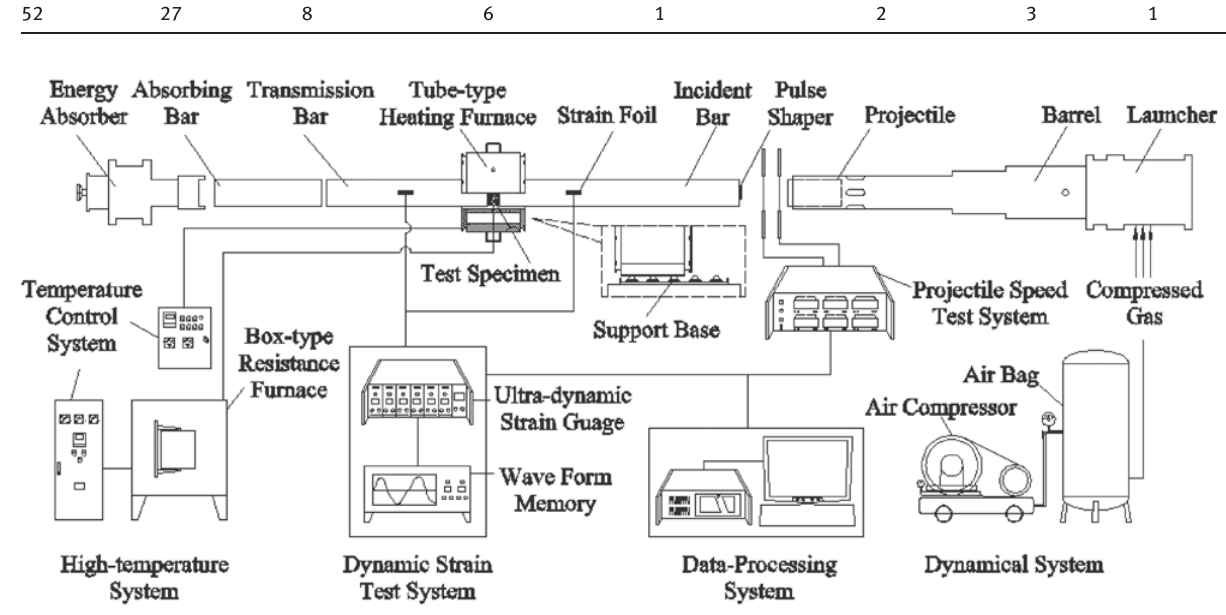
Table 1: The mineral composition of sandstone (%) Quartz